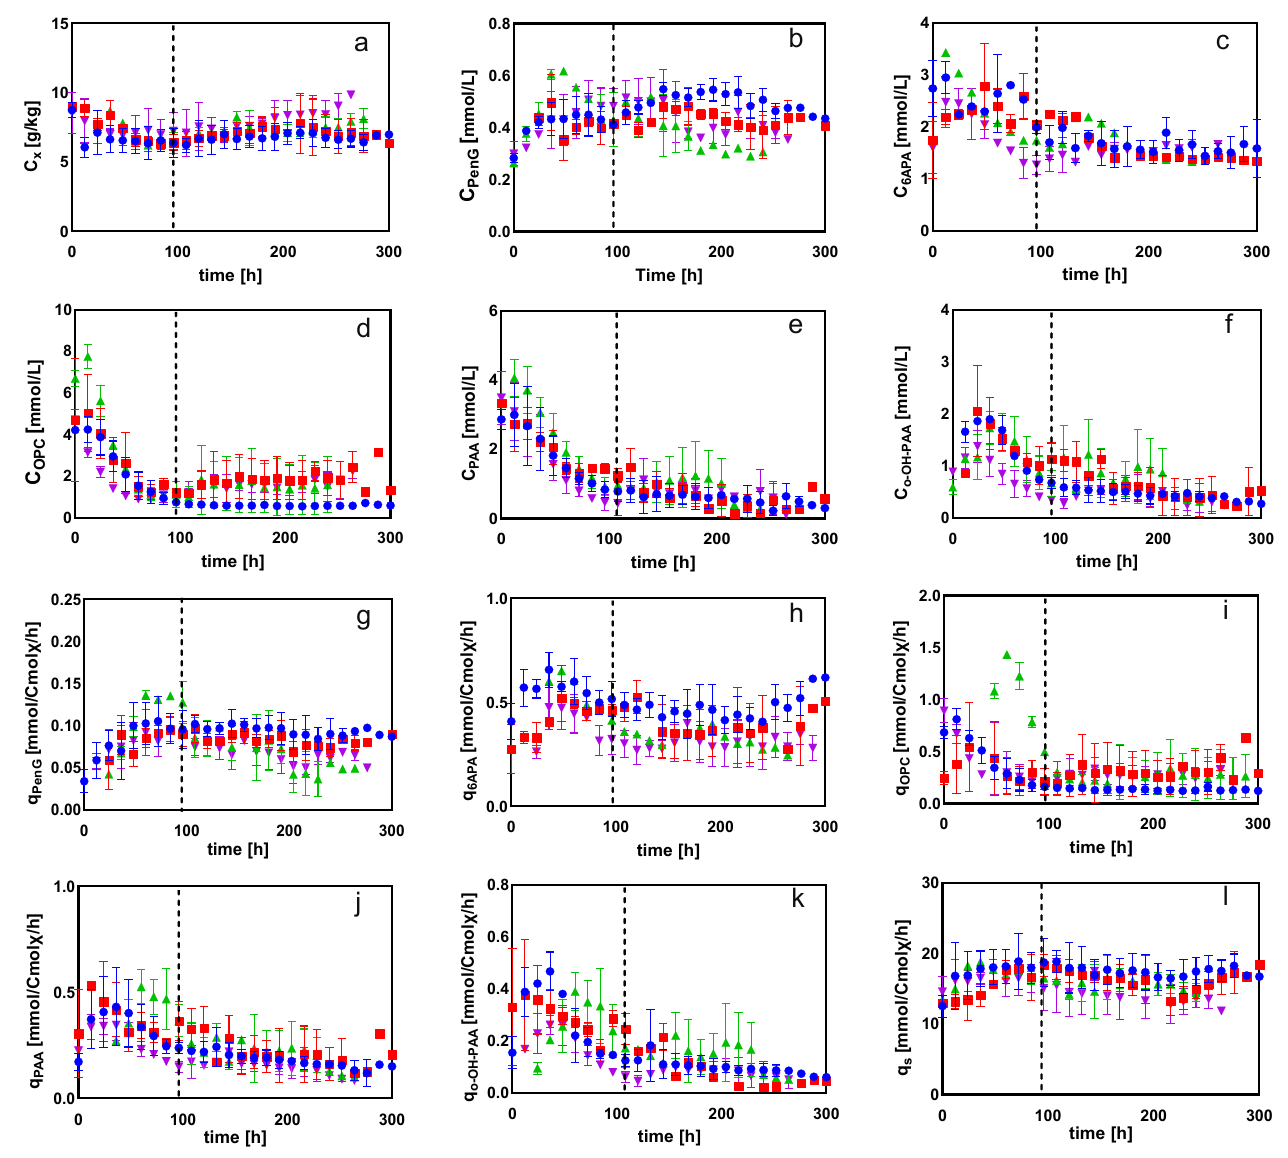
Figure 1. Measured concentrations of ( a ) biomass, ( b ) Penicillin G (PenG), ( c ) 6-aminopenicillanic acid (6APA), ( d ) 6-oxopiperidine-2-carboxylic acid (OPC), ( e ) phenylacetic acid (PAA), ( f ) ortho- hydroxyphenyl acetic acid (o-OH-PAA), ( g ) the biomass-specific penicillin production rate (q ), PenG ( h ) the biomass-specific 6-aminopenicillanic acid production rate (q ), ( i ) the biomass-specific 6APA 6-oxopiperidine-2-carboxylic acid production rate (q ), ( j ) the biomass-specific phenylacetic acid OPC consumption rate (q ), ( k ) the biomass-specific o-OH-PAA production rate (q ) and PAA o − OH − PAA ( l ) the biomass-specific substrate consumption rate (q ) at DO-shift experiments. The dashed line s represents the start of DO-shift experiment following 100 h chemostat cultivation at DO of 60%. Time 0 represents the start of chemostat cultivation. Different symbols signify different DO-shift experiments with ( • ) 60%, ( (cid:4) ) 20%, ( (cid:78) ) 10%, ( (cid:72) )